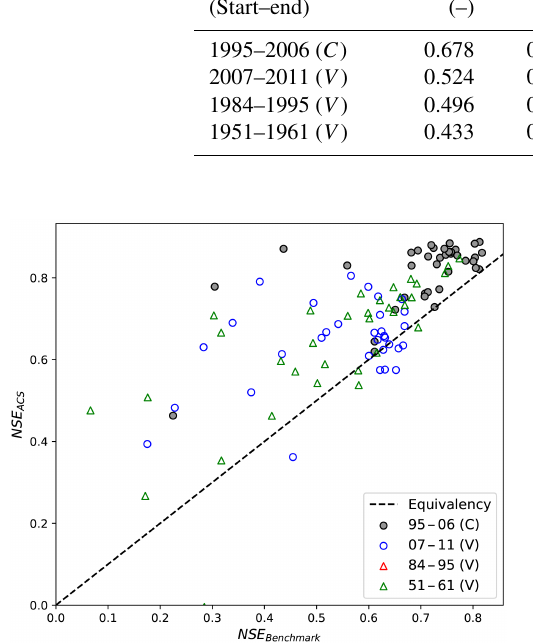
Figure 18. Nash–Sutcliffe efficiency of the ACS-based model and benchmark model; all zonal parameters